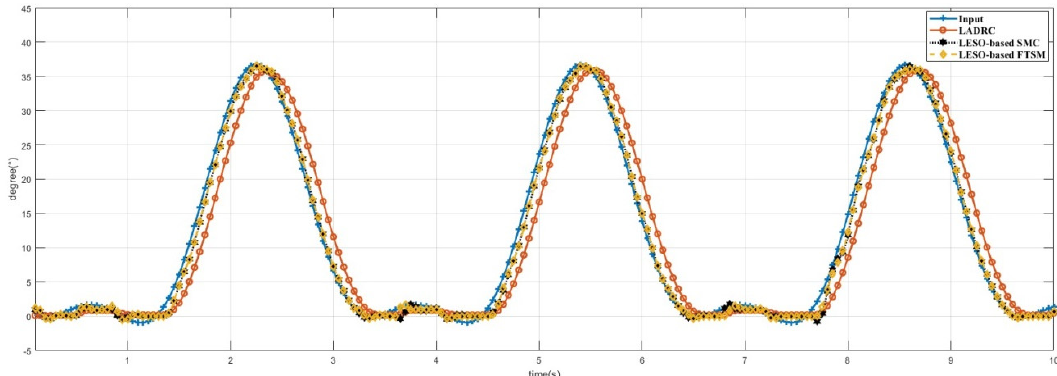
Figure 9. Trajectories of hip joint at walking speed = 0.15 m/s.